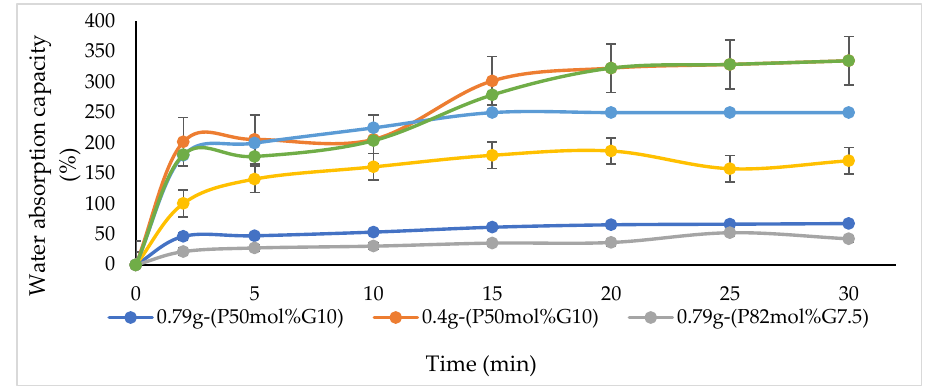
Figure 4. Water absorption capacity varying blend scaffolds.